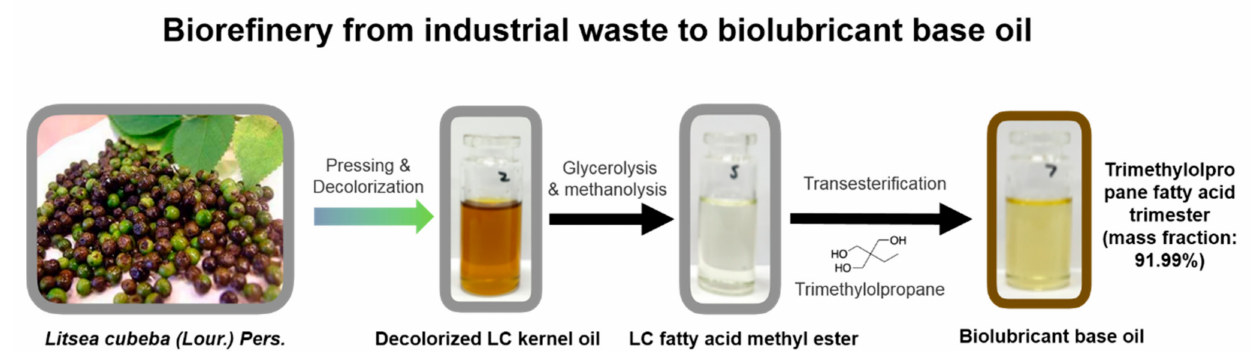
Figure 3. Sustainable biorefinery route for the production of biolubricant base oils from Litsea cubeba (LC) kernels as waste residues after the essential oil